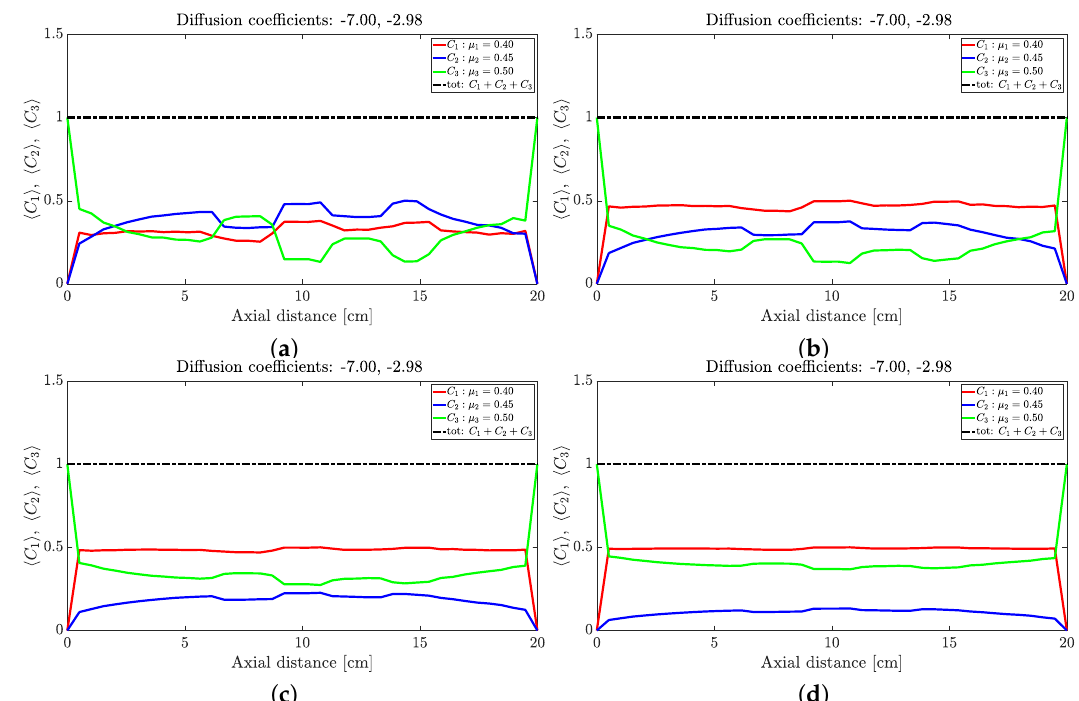
Figure 5. Snapshots of ternary mixture at: ( a ) 200 s, ( b ) 500 s, ( c ) 1000 s, ( d ) 2000 s. The corresponding diffusion coefficients are − 7 and −